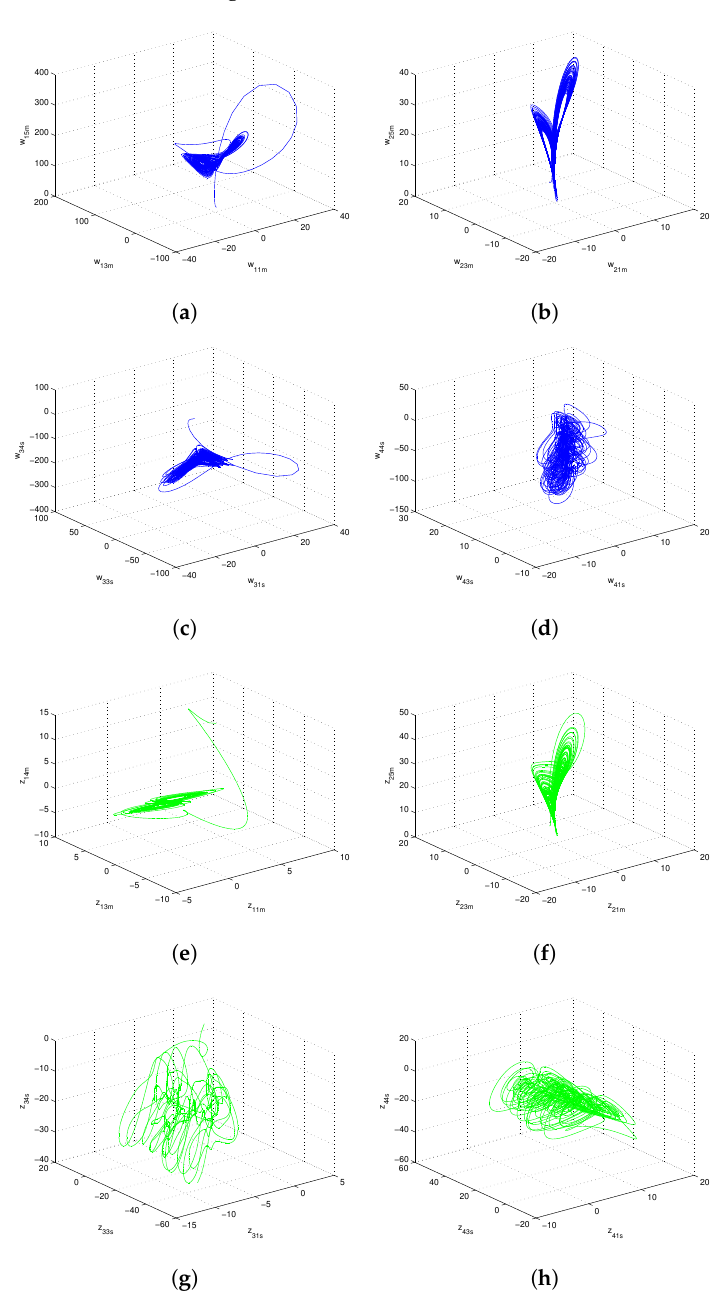
Figure 1. Phase diagrams of fractional complex systems and fractional hyperchaotic system for (16)–(23) at q = 0.95; ( a ) Lorenz chaotic attractor system in w 11 m − w 13 m − w 15 m space; ( b ) T chaotic attractor system in w 21 m − w 22 m − w 23 m space; ( c ) Lu chaotic attractor system in w 31 s − w 32 s − w 33 s space; ( d ) Chen chaotic attractor system in w 41 s − w 42 s − w 43 s space; ( e ) Xling chaotic attractor in z 11 m − z 12 m − z 13 m space; ( f ) van der Pol chaotic attractor system in z 21 m − z 22 m − z 23 m space; ( g ) Rabinovich chaotic attractor system in z 31 s − z 32 s − z 33 s space; ( h ) Rikitake chaotic attractor system in z 41 s − z 42 s − z 43 s